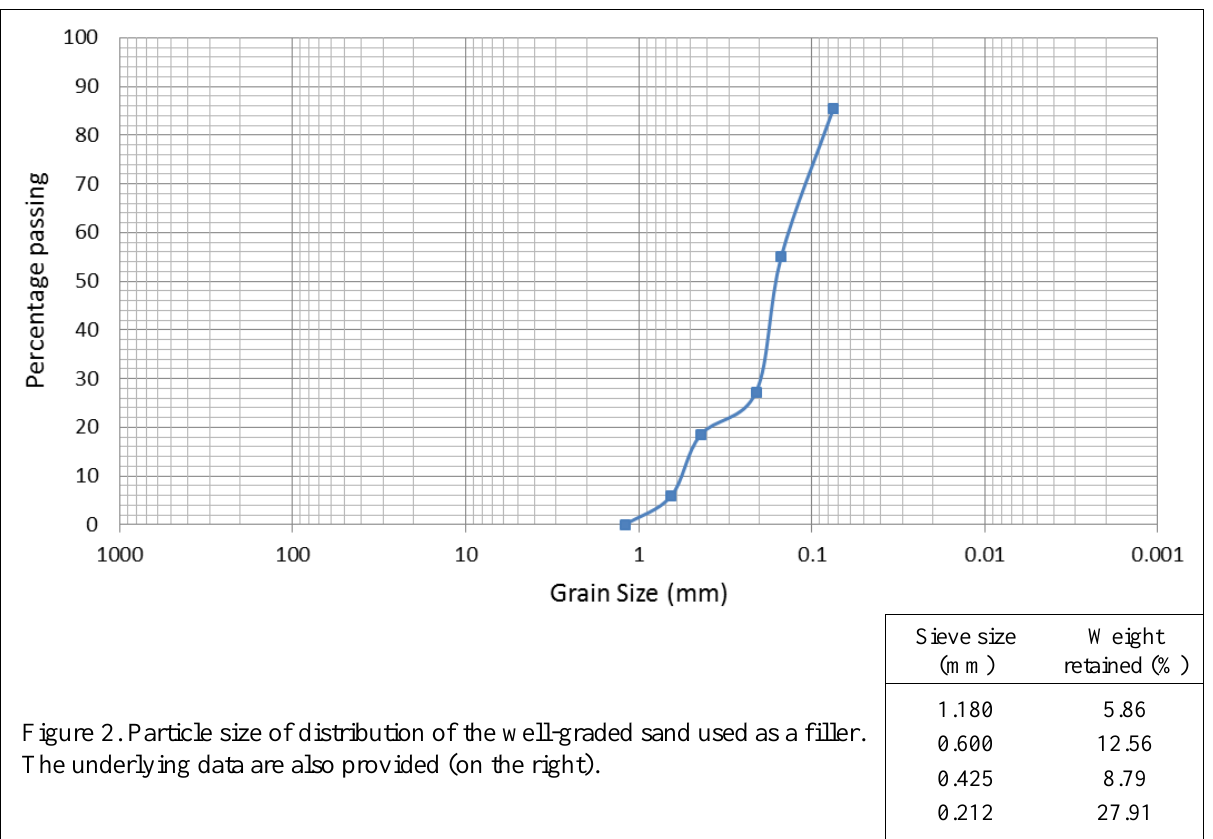
Figure 2. Particle size of distribution of the well-graded sand used as a filler. The underlying data are also provided (on the right).